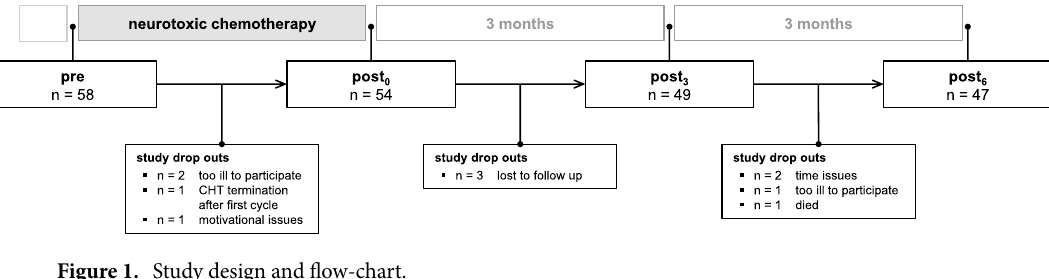
Figure 1. Study design and